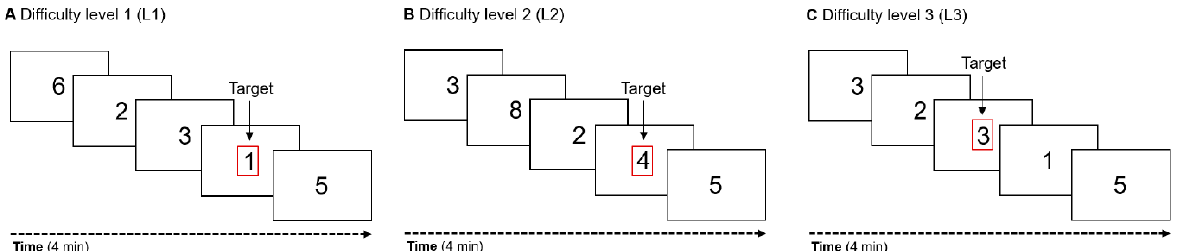
Figure 3. Illustration of the three difficulty levels of the N-back task. Participants were instructed to press a button as fast as possible whenever a target appeared. Each condition contained 150 stimuli (50 targets) that appeared on the screen for 1600 ms each. ( A ) Participants were instructed to press a button whenever the digit ‘1’ appeared on the screen. ( B ) Participants had to press a button when three digits in a row were even. ( C ) Participants were asked to press a button when the digit was identical to the second to last digit.